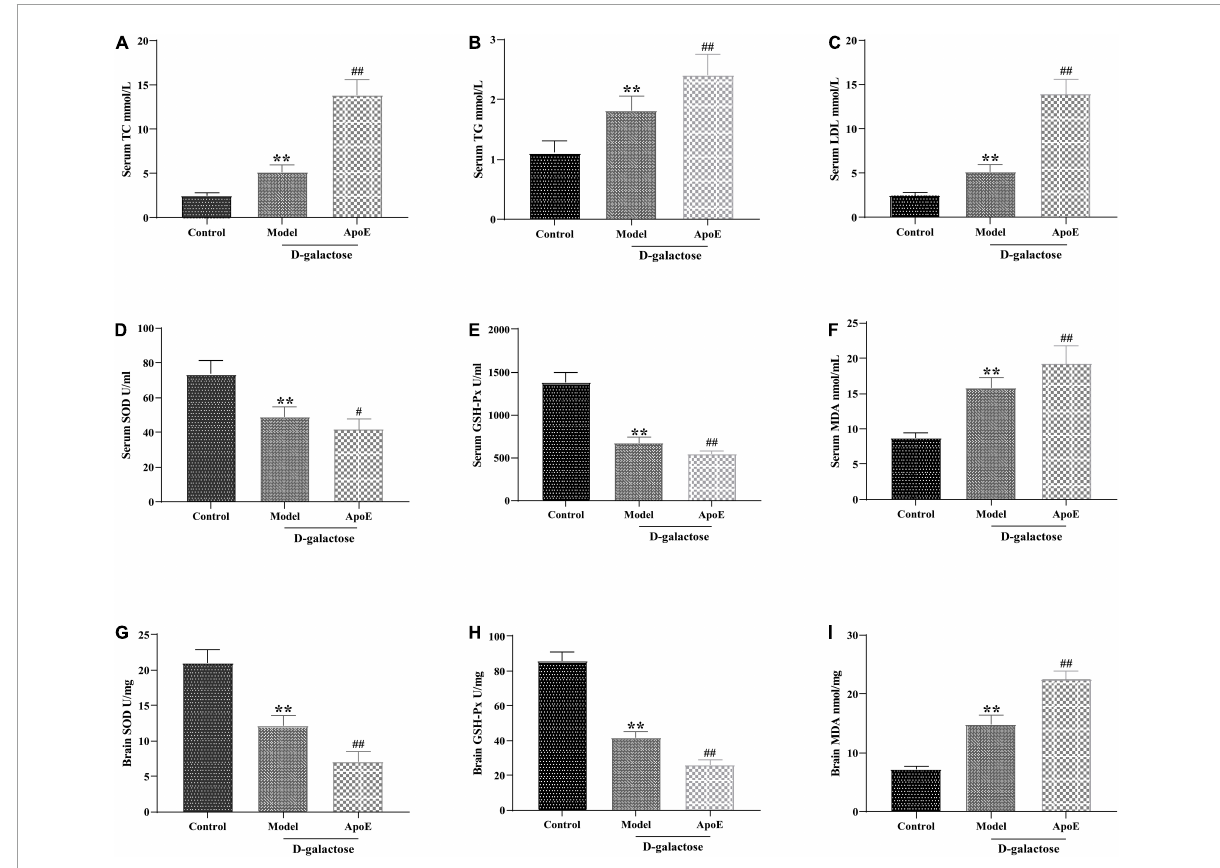
FIGURE7 Deletion of ApoE alters blood lipids and oxidative stress levels in rapidly aging mice. (A) TC, n = 8. (B) TG, n = 8. (C) LDL, n = 8. (D) SOD in serum, n = 8. (E) GSH-Px in serum, n = 8. (F) MDA in serum, n = 8. (G) SOD in brain tissue, n = 8. (H) GSH-Px in brain tissue, n = 8. (I) MDA in brain tissue, n = 8. ** p < 0.01 vs. Control group. # p < 0.05, ## p < 0.01 vs. Model